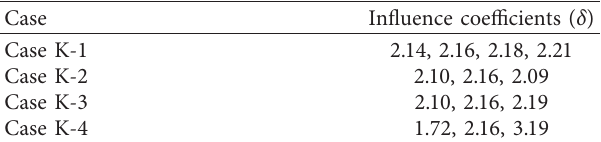
Table 14: Influence coefficients of K-shaped connection in dif- ferent